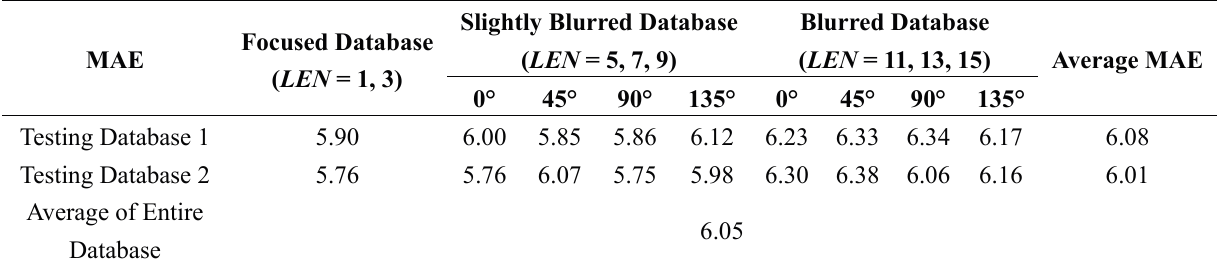
Table 13. Estimation performances of our age estimation method using motion blur